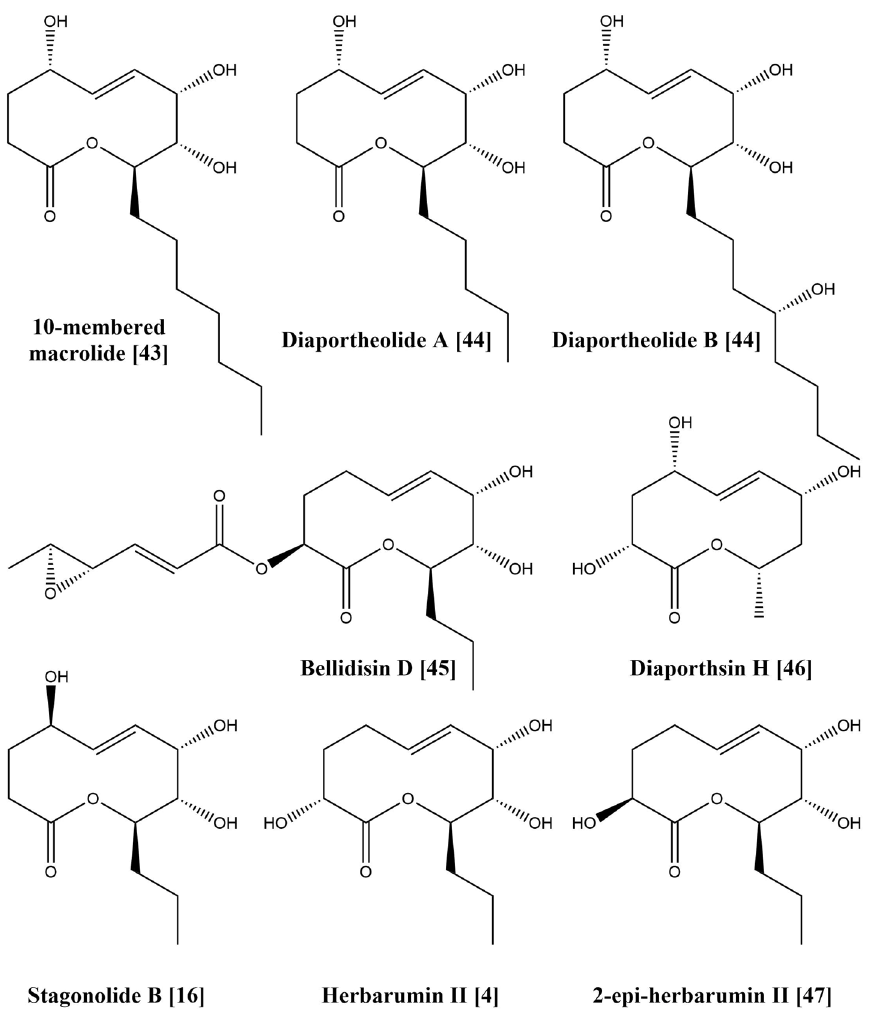
Figure 4. Structurally related fungal ten-membered